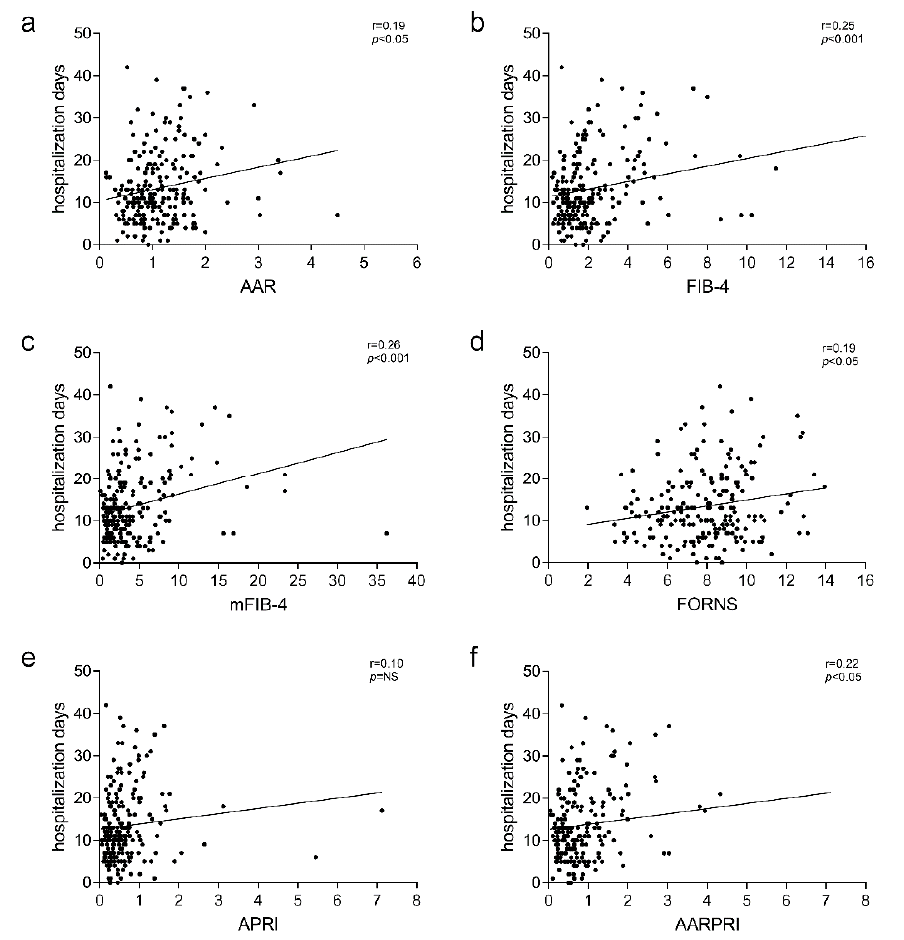
Figure 4. Correlation of AAR ( a ), FIB-4 ( b ), mFIB-4 ( c ), FORNS ( d ), APRI ( e ), AARPRI ( f ) with hospitalization days in discharged patients. The correlation was analysed and estimated using Pearson’s Correlation Coefficient (r). ( p ) indicates statistical significance. Each black dot represents a single patient. Abbreviations: AST to ALT ratio: AAR; fibrosis 4 index: FIB-4; modified FIB-4: mFIB-4; AAR to Platelet ratio: AARPRI.